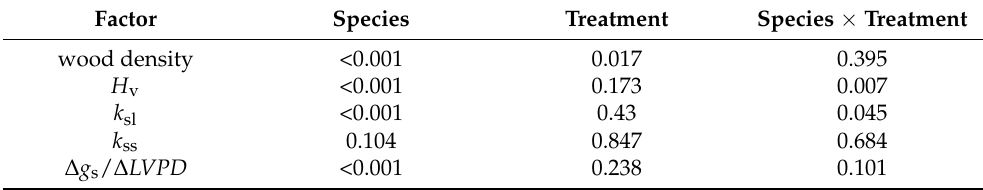
Table 2. Probabilities determined by ANOVA for species, treatment, and species × treatment effects on wood density, Huber value ( H v ), whole-plant leaf area-specific hydraulic conductance ( k sl ), whole- plant sapwood-specific hydraulic conductance ( k ss ), and stomatal sensitivity to LVPD ( ∆ g s / ∆ LVPD ). Factor Species Treatment Species × Treatment wood density <0.001 0.017 0.395 H v <0.001 0.173 0.007 k sl <0.001 0.43 0.045 k ss 0.104 0.847 0.684 ∆ g ∆ LVPD <0.001 0.238 s /